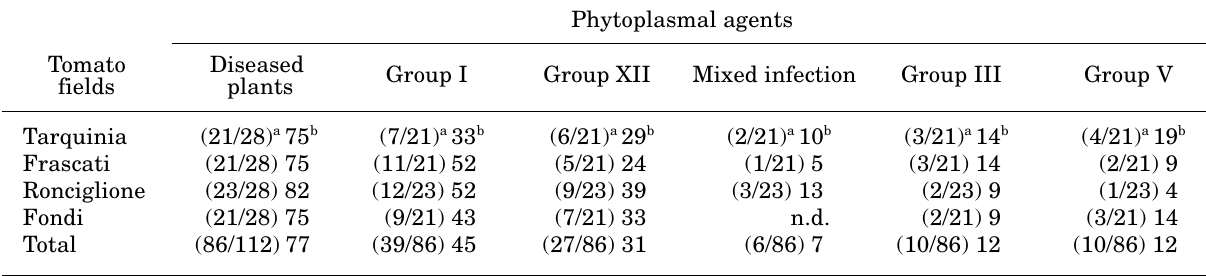
Table 2. Percentage of phytoplasmas from different 16S rRNA groups detected in tomato plants in Latium, Italy, in the summer 2000. It was not possible to characterise the phytoplasmas present in some positive samples because of the unclear RFLP